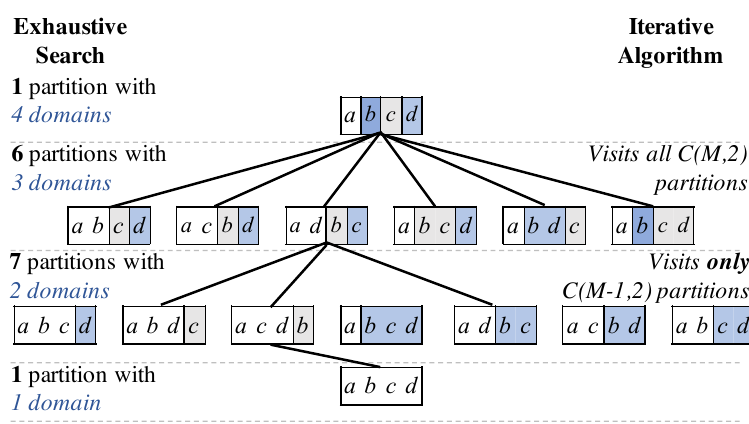
Figure 3. Illustration of the VF partitioning